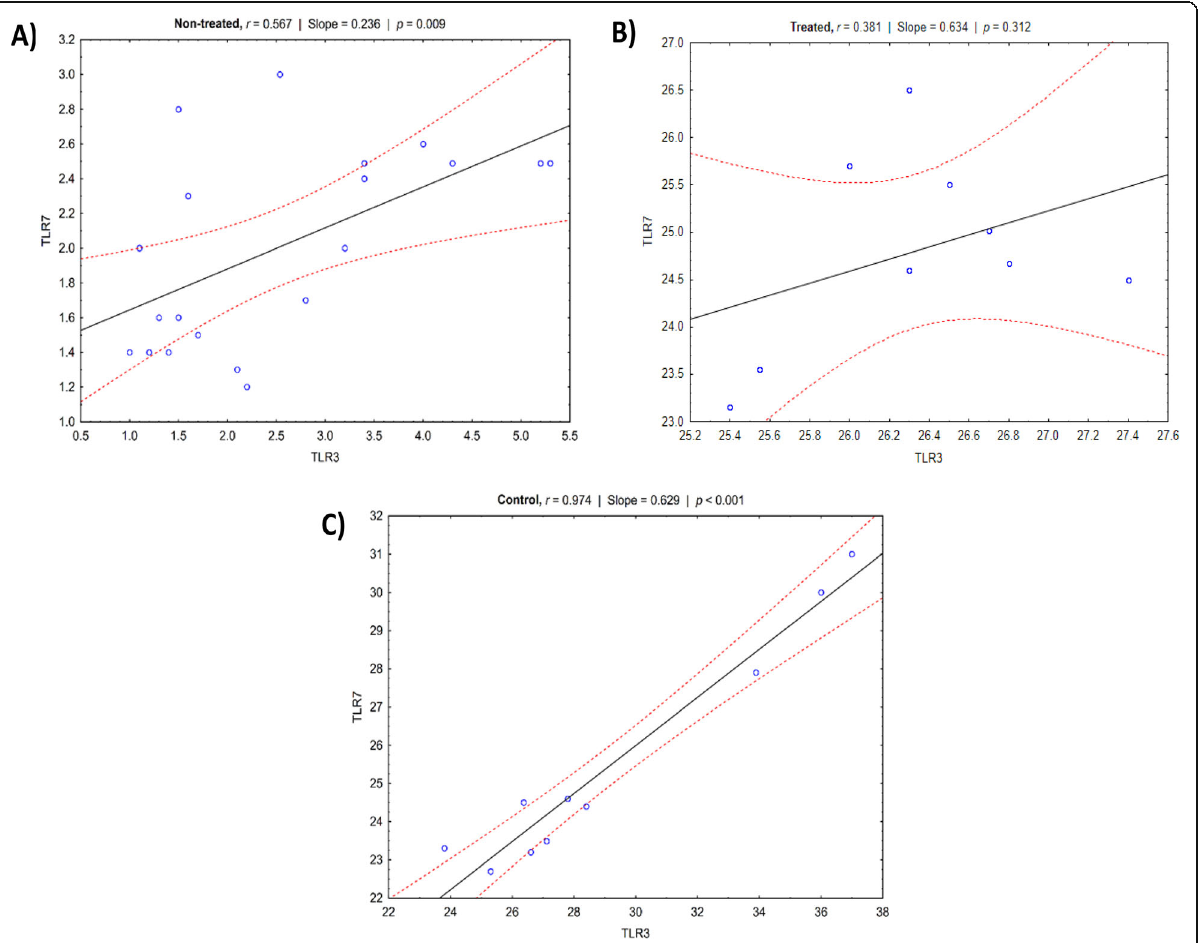
Fig. 6 a The correlation between expression levels of TLR3 and TLR7 in non-treated chronic HCV patients. b The correlation between expression levels of TLR3 and TLR7 in treated HCV group. c The correlation between expression levels of TLR3 and TLR7 in the control group